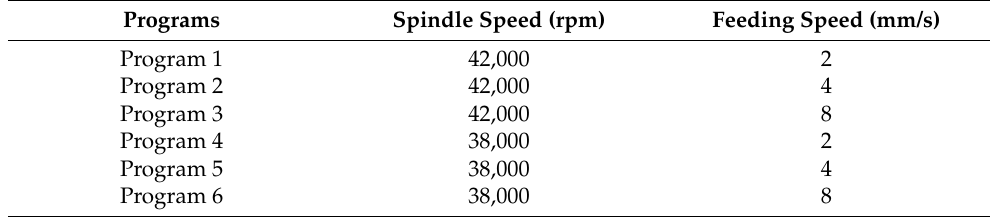
Figure 2. PCB processing. Table 3. Milling experiment